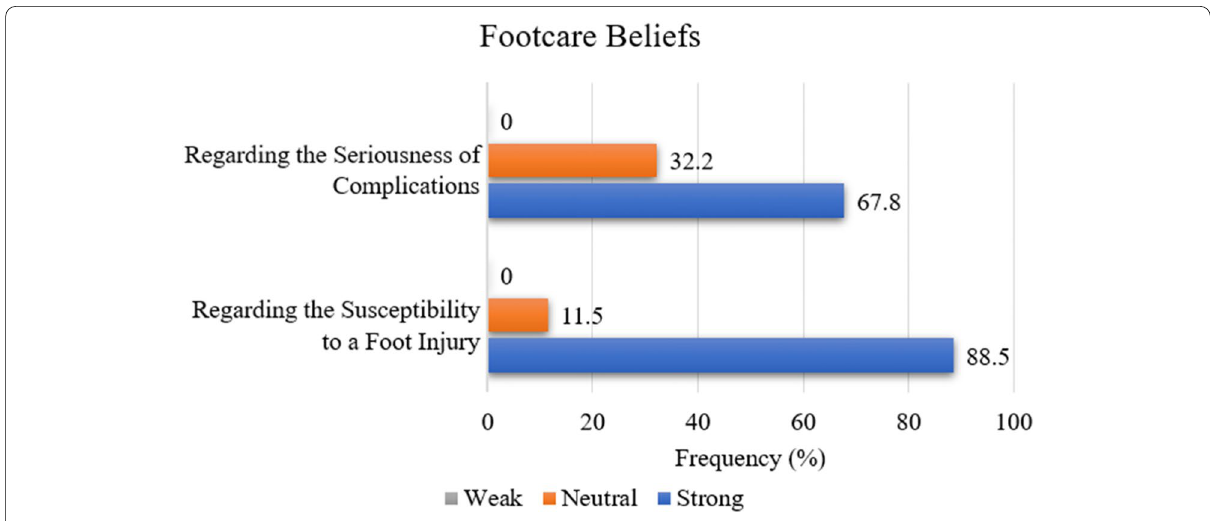
Fig. 4 Distribution of footcare beliefs ( n